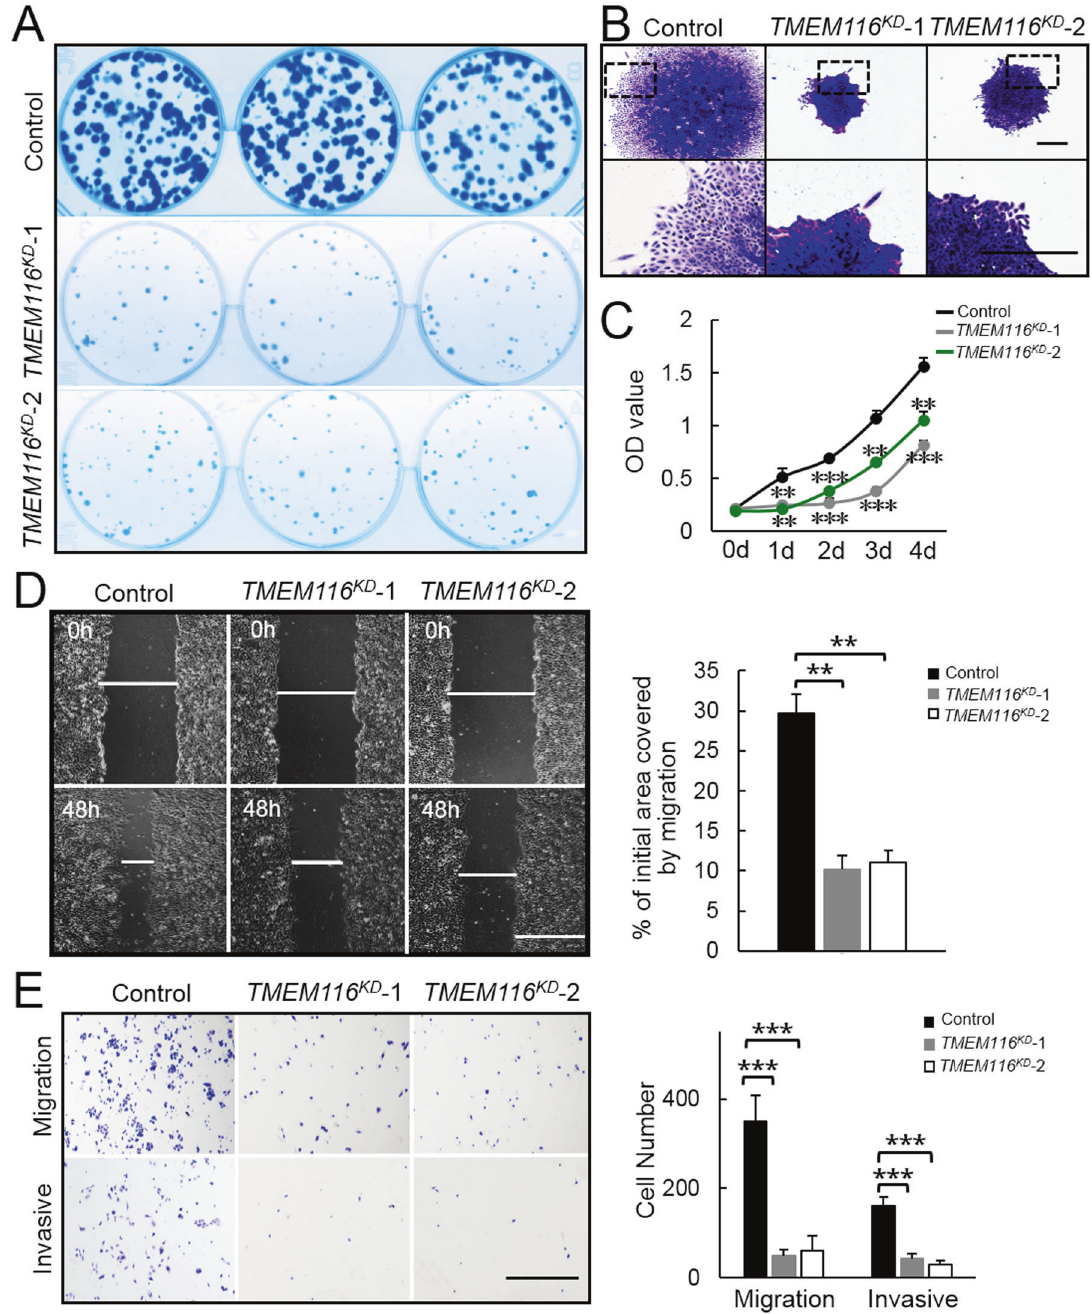
Fig. 3 TMEM116 de fi ciency inhibits scattered cell growth, clone formation, cell proliferation, invasion and migration. A TMEM116 KD and control cells were subjected to colony formation assays. B TMEM116 KD and control cells were subjected to colony morphology assays. Scale bar: 500 μ m. C TMEM116 KD and control cells were subjected to CCK-8 proliferation assay. D TMEM116 KD and control cells were subjected to wound-healing assay. Scale bar: 1000 μ m. Representative images from over 30 non-overlapping fi elds at each time point are shown. E TMEM116 KD and control cells were subjected to Transwell migration and invasion assays. Scale bar: 1000 μ m. The bars represent the mean ± SD. * P < 0.05, ** P < 0.01, *** P < 0.001. Representative images from three independent experiments are shown